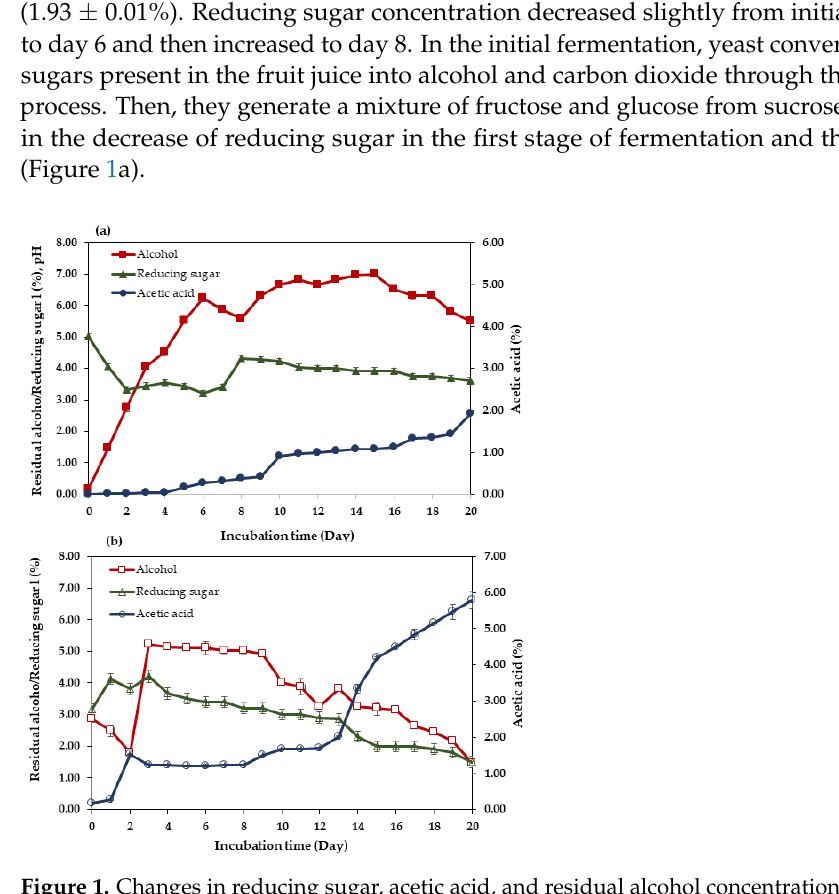
Figure 1. Changes in reducing sugar, acetic acid, and residual alcohol concentrations of fruit vinegar in one-step fermentation ( a ) and sequential fermentation ( b